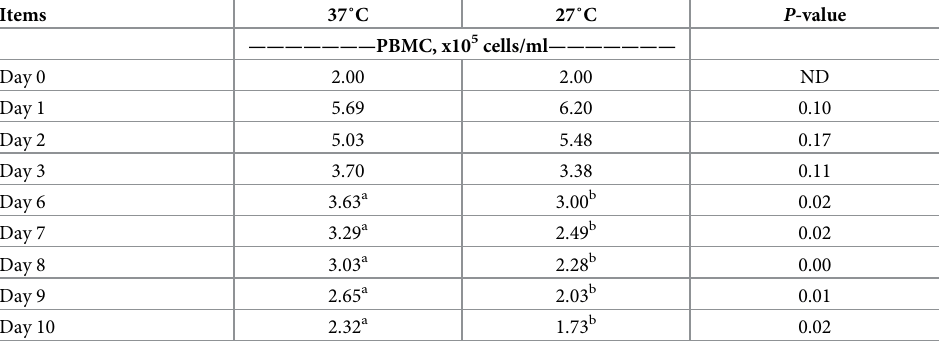
a,b Median values with different superscript letters within the same row were statistically significant (Wilcoxon test, P < 0.05). ND = not determined.